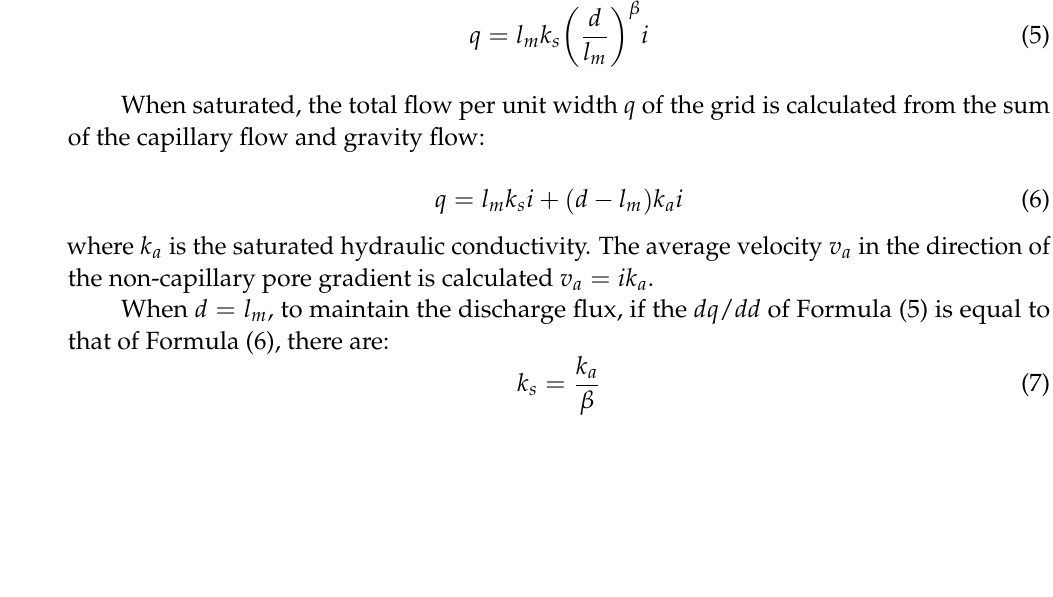
Figure 4. The diagram of the mechanism of surface–subsurface slope runoff generation.